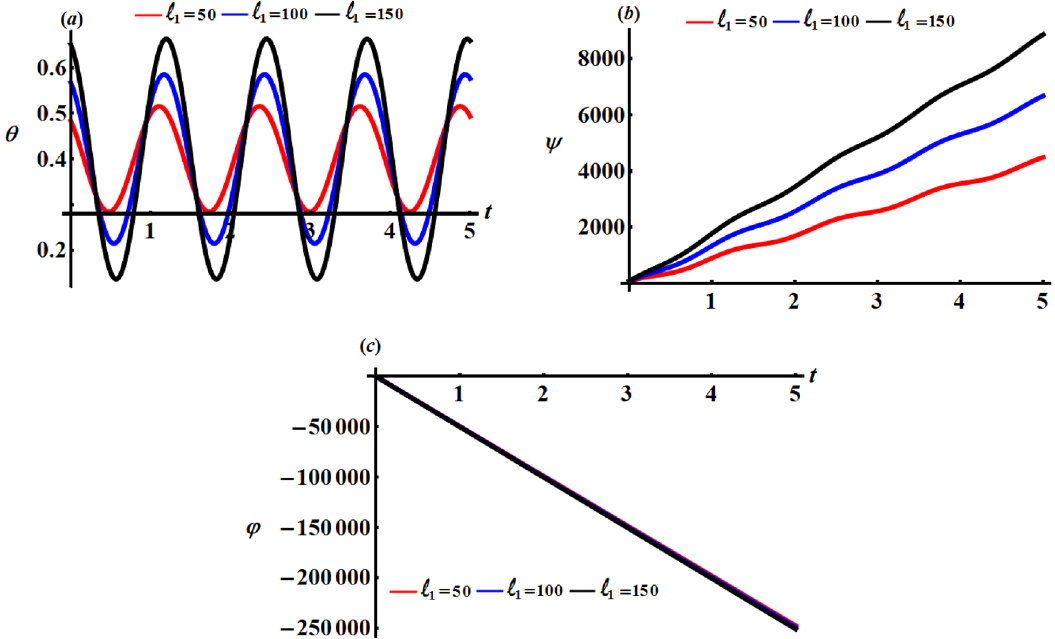
Figure 8. Describes the behaviour of the Euler’s angles at ℓ 1 (